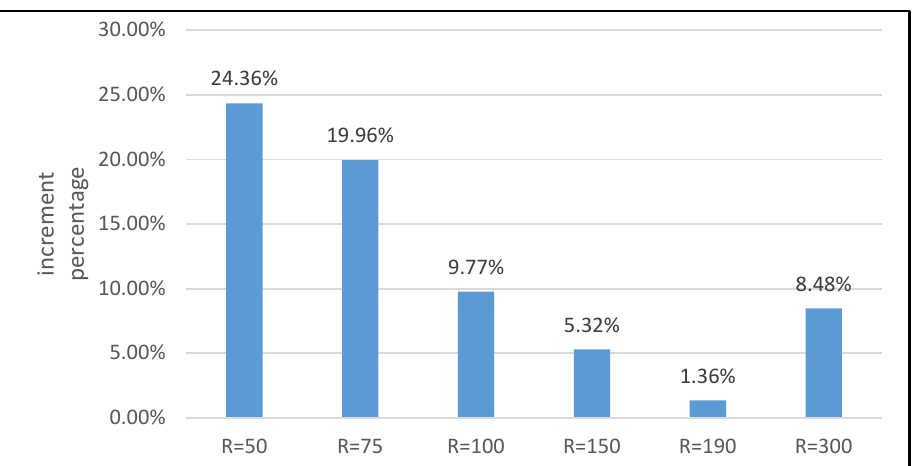
Fig. 8. Negative moment impact factors for different radii